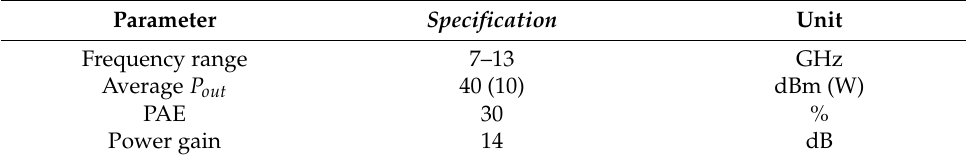
Table 1. Requirements for 7–13 GHz MMIC